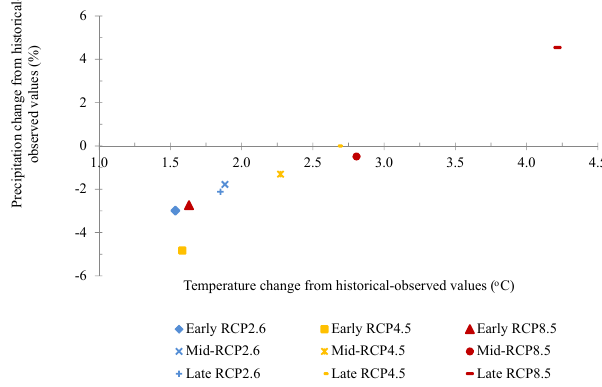
Table 4. Carbon dioxide concentration (ppm) values used in SWAT simulations.